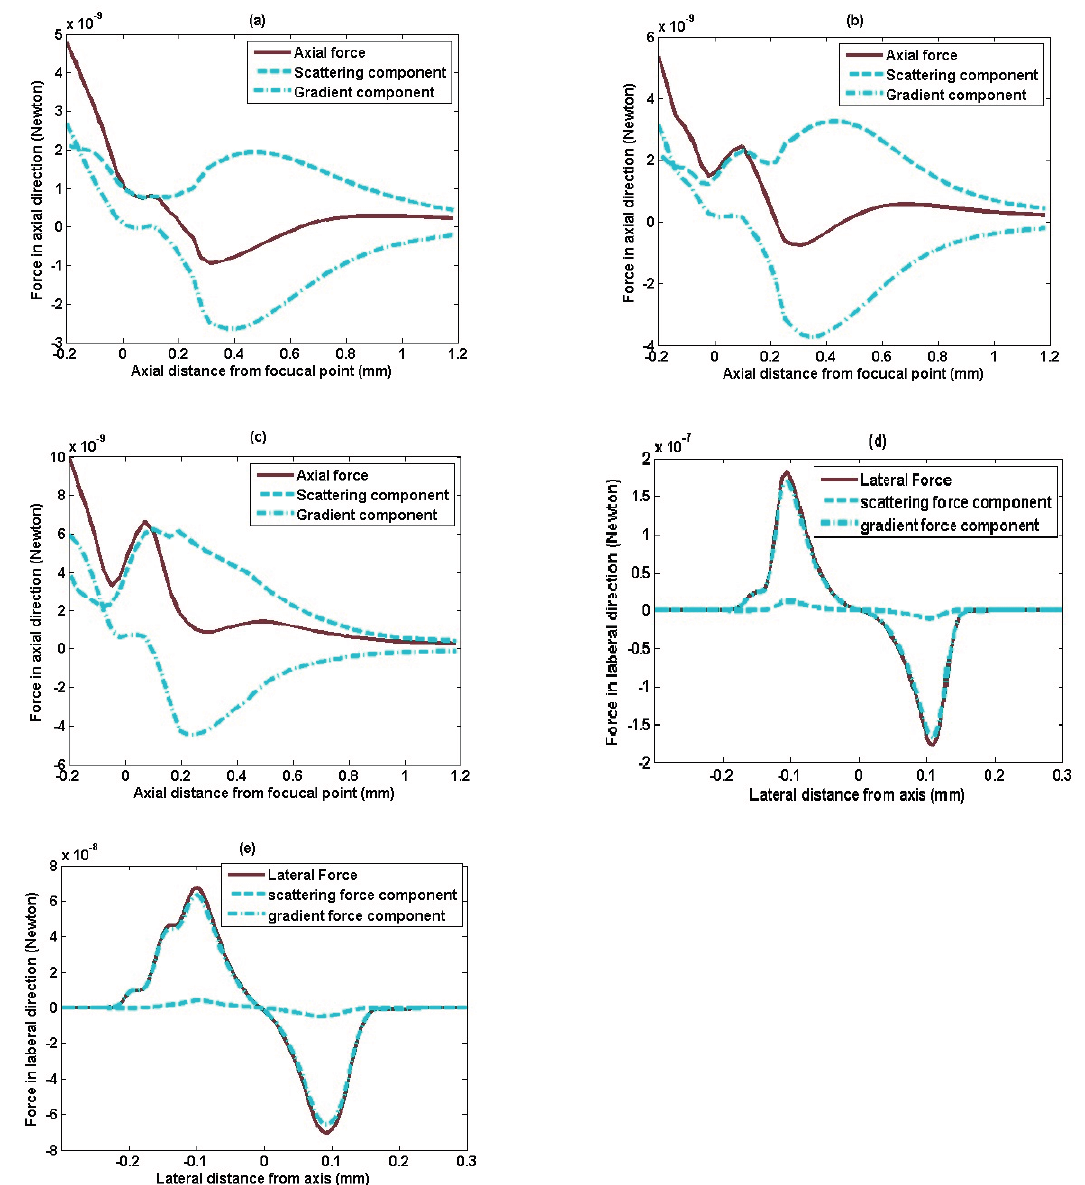
Figure 6. Acoustic radiation force along and across the beam propagation direction. The diameter of the particle is 240 μ m in coordinate system zoy. ( a ) Axial radiation force as the particle location varies from ( − 0.2, 0) to (1.2, 0) mm; ( b ) Axial radiation force as the particle location varies from ( − 0.2, 0.02) to (1.2, 0.02) mm; ( c ) Axial radiation force as the particle location varies from ( − 0.2, 0.05) to (1.2, 0.05) mm;( d ) Lateral radiation force as the particle location varies from (0.13, − 0.3) to (0.13, 0.35) mm; ( e ) Lateral radiation force as the particle location varies from (0.23, − 0.3) to (0.23, 0.35)